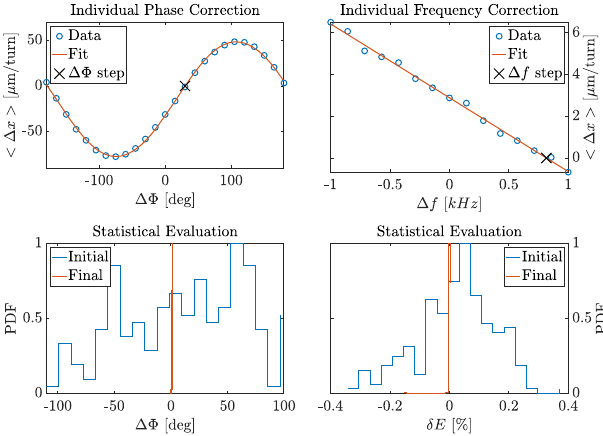
FIG. 13. Results of the rf phase (left) and frequency (right) correction. Shown are the mean horizontal TBT BPM variation and the corresponding fit functions for an individual correction step (top) and a statistical evaluation of the final results (bottom) over many